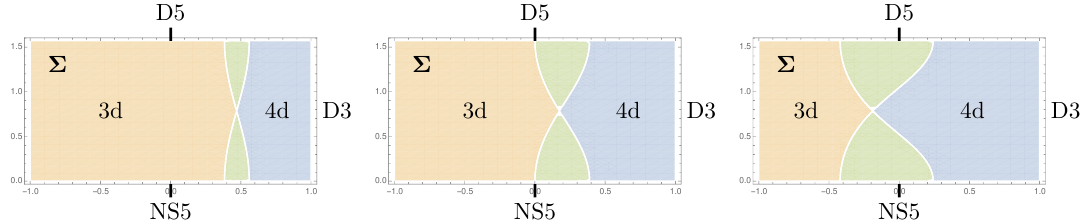
Figure 3. Regions on the strip Σ for the BCFT duals (2.8) according to which type of loop operators they host, from left to right for N 5 /K ∈ { 4 , 2 , 1 } . The horizontal axis is tanh(Re( z )) , the vertical axis Im( z ) . The 3d part hosts Wilson and vortex loop operators on the defect, the 4d part hosts neither, while the transition regions host either Wilson or vortex loops on the defect but not both (see also figure